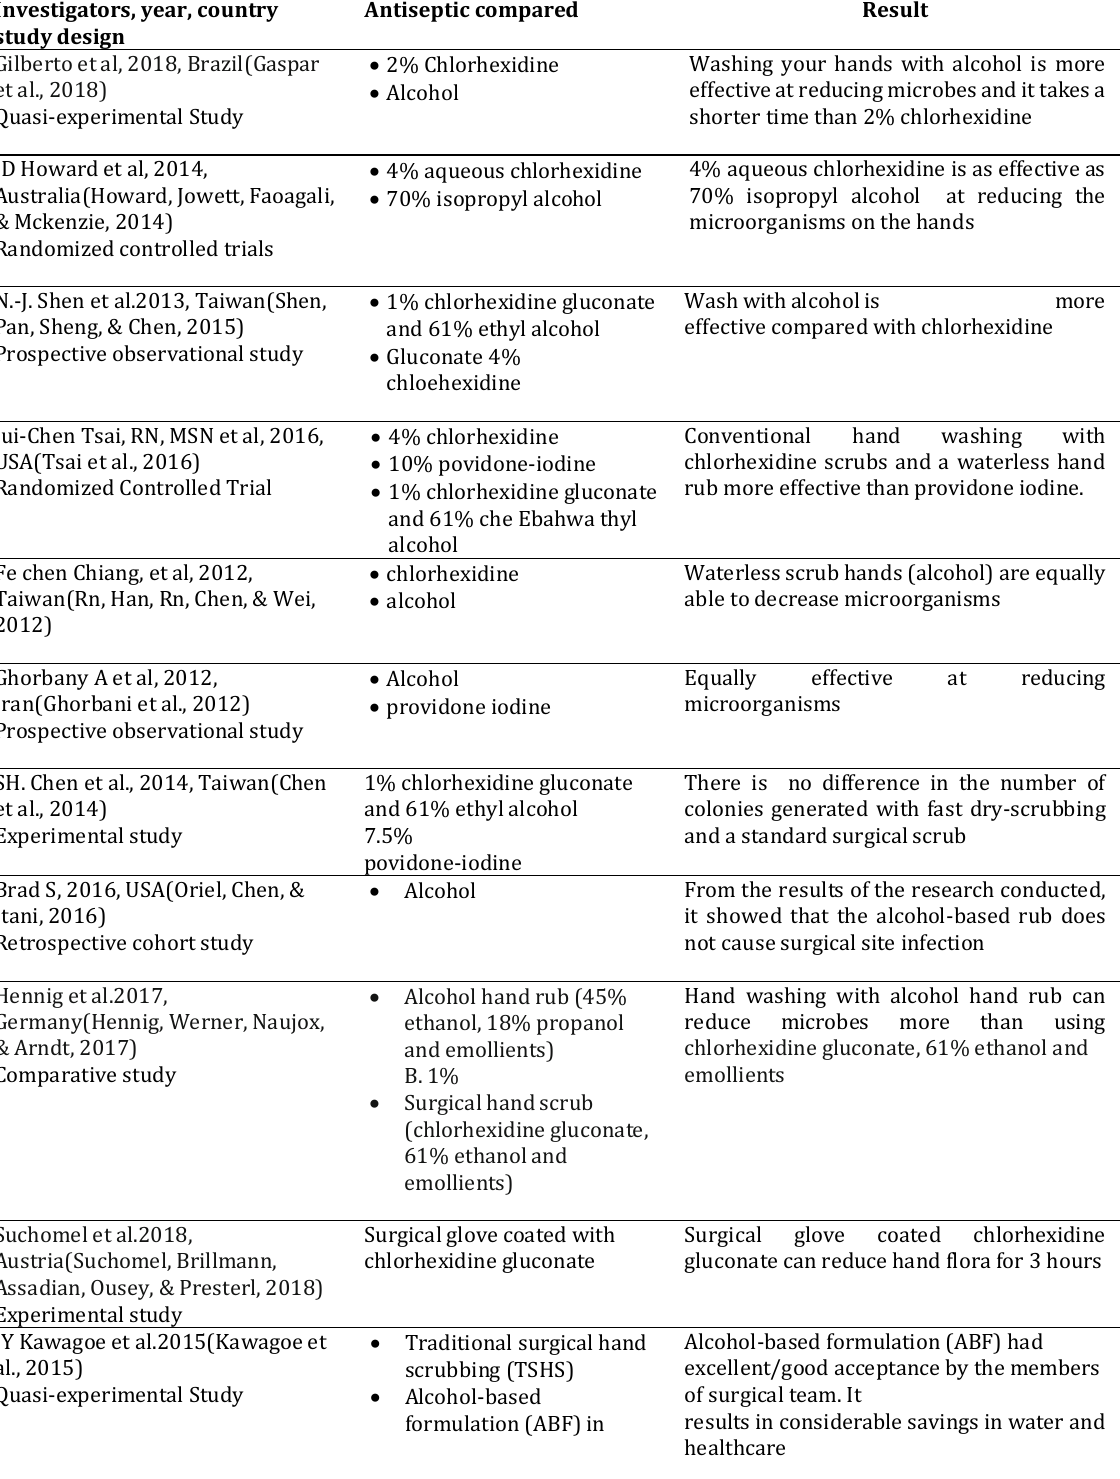
Table 2. List of Articles About the Use of Chlorhexidine, Providone Iodine and Alcohol Investigators, year,